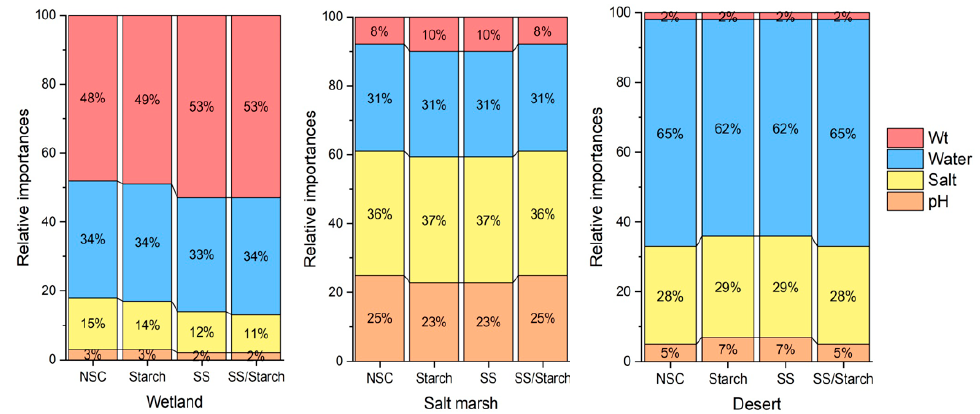
Figure 5. Relative importance of soil environmental factors to reed NSC and its components in different habitats (Wt represents soil bulk density; SS represents soluble sugar).